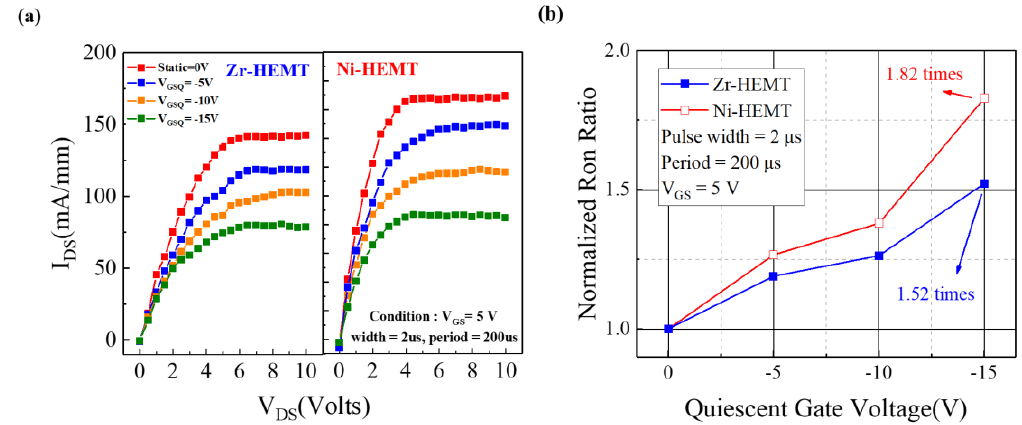
Figure 6. ( a ) Pulse I DS –V DS characteristics, and ( b ) dynamic R on ratio of the Zr-HEMT and Ni-HEMT at different V GSQ .